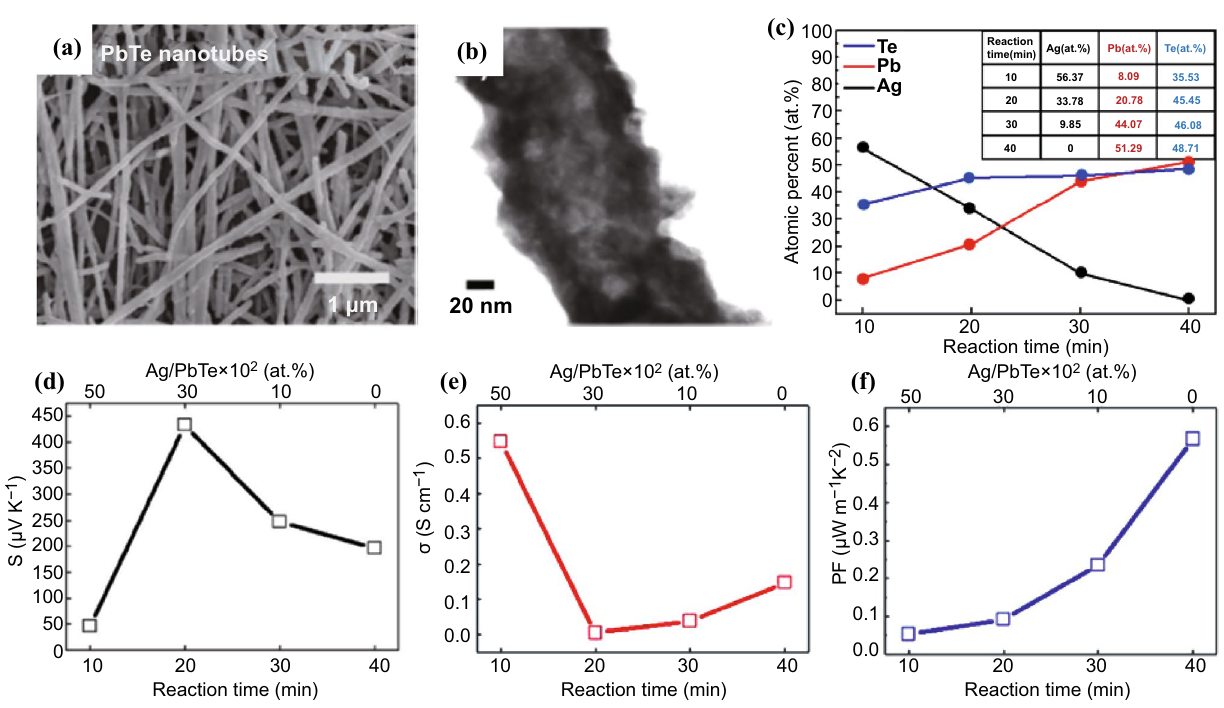
Fig. 11 a SEM and b TEM images of PbTe nanotubes fabricated via combined electrospinning, electrodeposition and cationic exchange reac- tion. c Stoichiometry ratio of different cation exchange reaction time from Ag 2 Te to PbTe. Different reaction time of d Seebeck coefficient , e electrical conductivity and f power factor of PbTe, included 10–50% of Ag content in the 1D Ag x Te y –PbTe composite nanotubes. Adapted with permission from Ref.